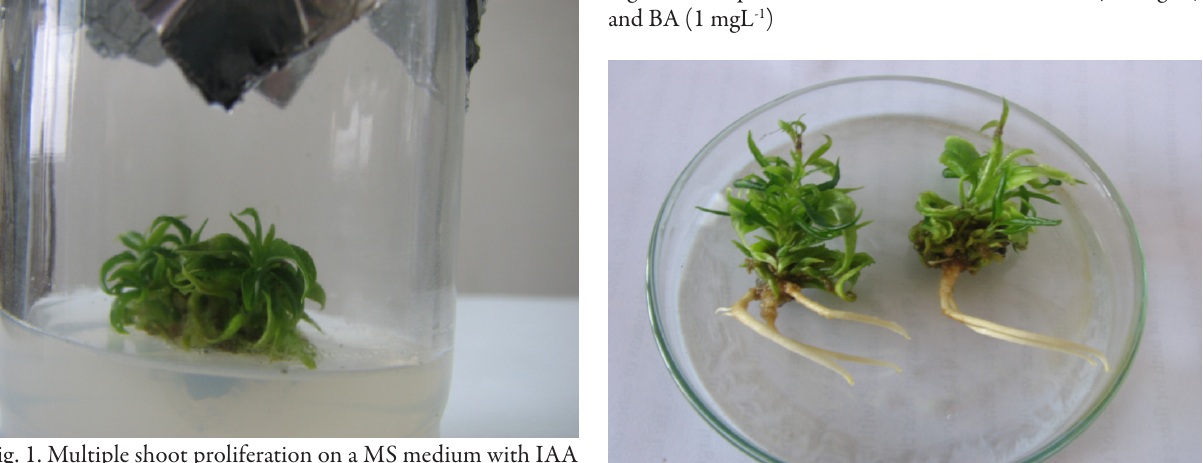
Fig. 2. Developed shoot on a MS medium with IAA (0.5 mgL -1 )